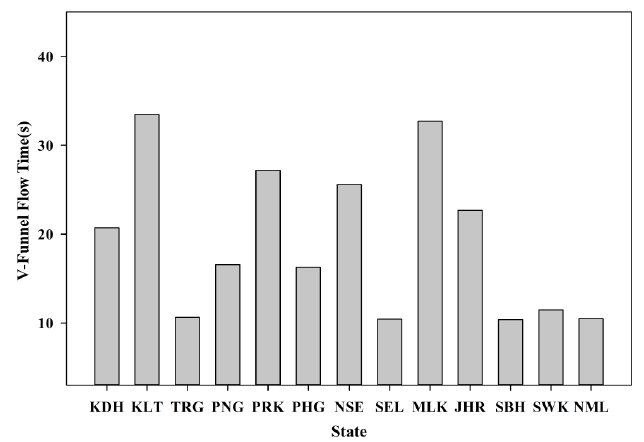
Figure 11. V-Funnel flow time results.